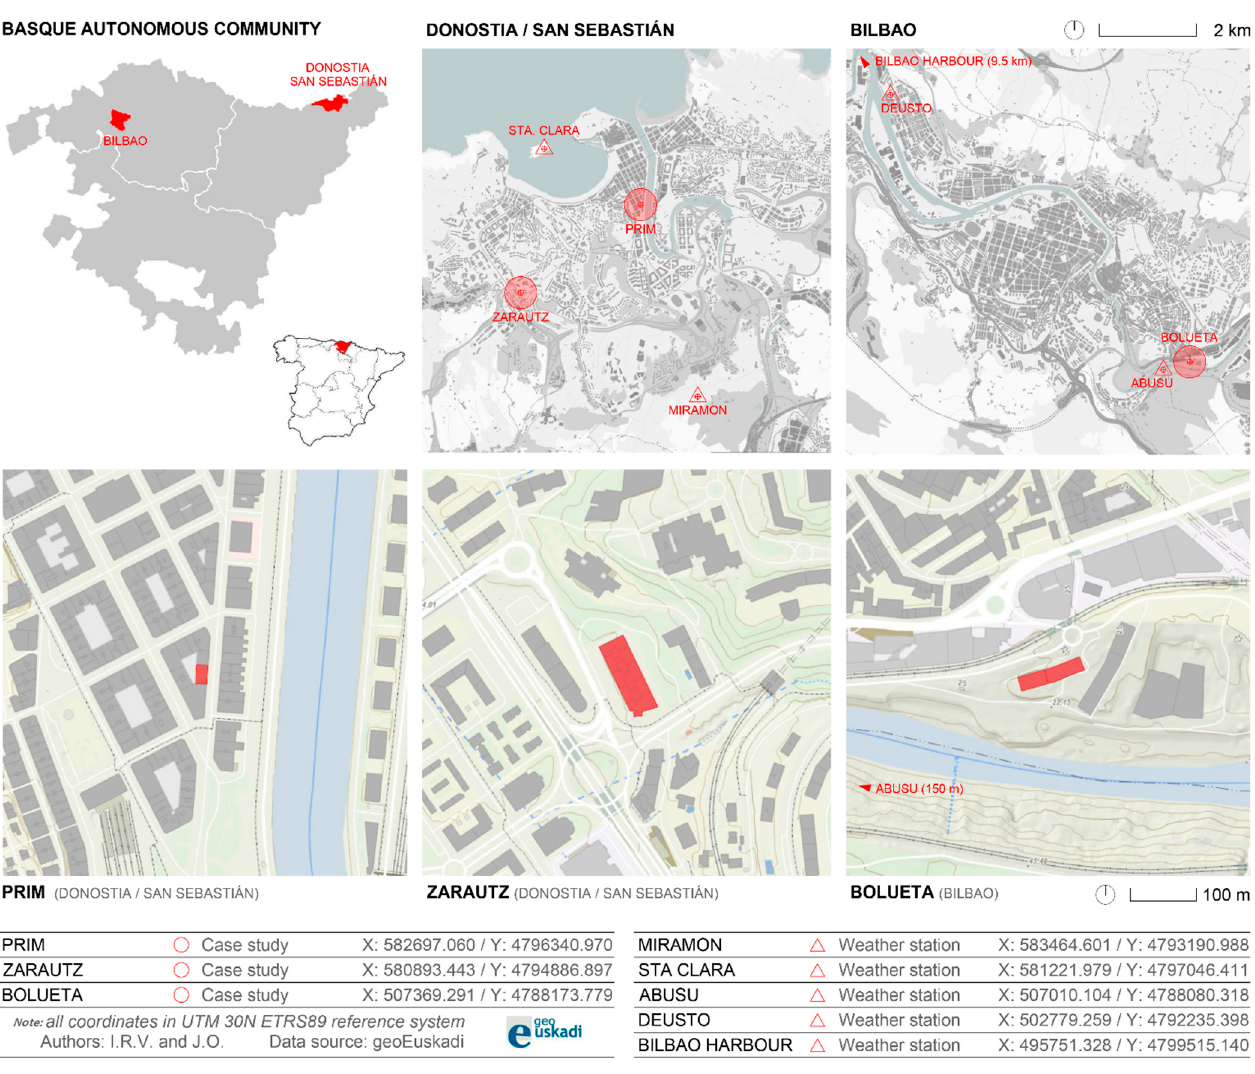
Figure 2. Location of the case studies and meteorological stations used in this study, in Donostia- San Sebastián and Bilbao. Source: authors. Original images were obtained from geoEuskadi, public SIG service of the Basque Country.